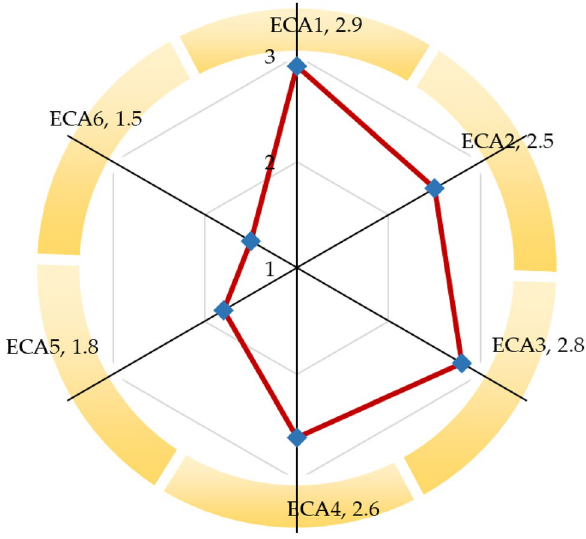
Figure 6. Sustainability evaluation of ELV recycling system from economic dimensions.